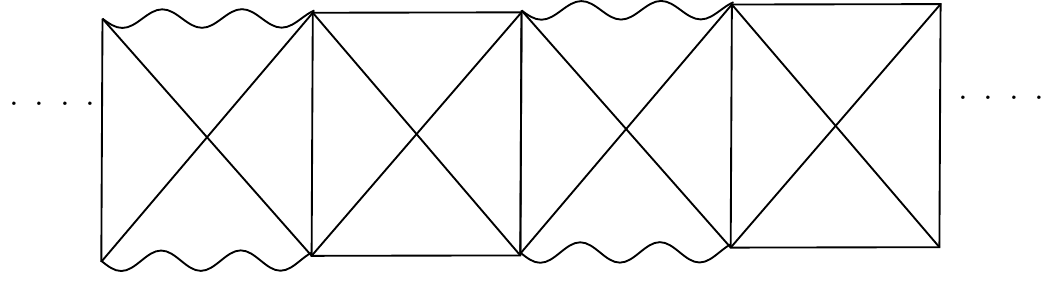
Figure 9 . Maximal extended Penrose diagram for